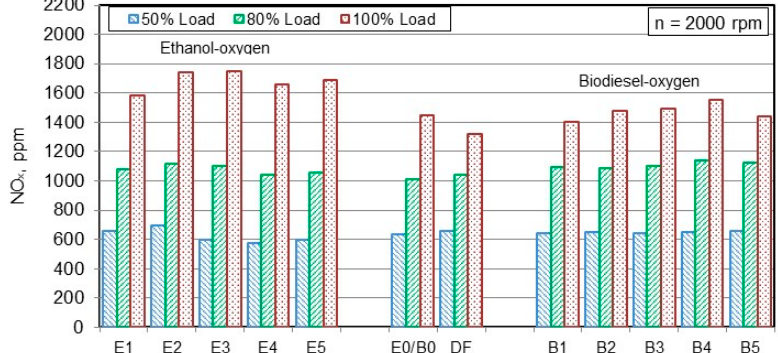
Figure 12. The changing trends in total nitrogen oxide (NO x ) emissions as a function of ethanol–oxygen or biodiesel-oxygen mass content (wt%) in fuel blends for medium (50%), intermediate (80%), and full (100%) loads corresponding to the respective IMEPs of 0.75, 1.20, and 1.50 MPa developed at maximum torque speed of 2000 rpm.